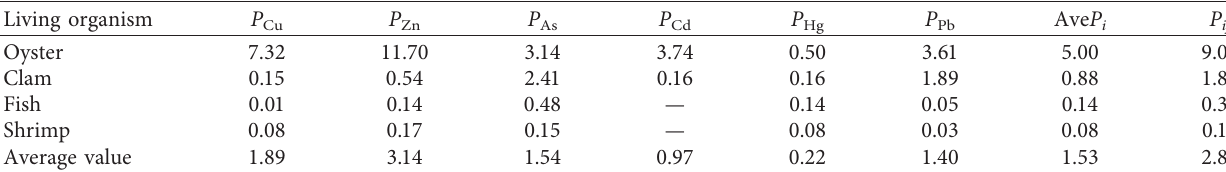
2.0 i ) and comprehensive pollution index ( P ij ) for single-factor heavy metal pollution in various living